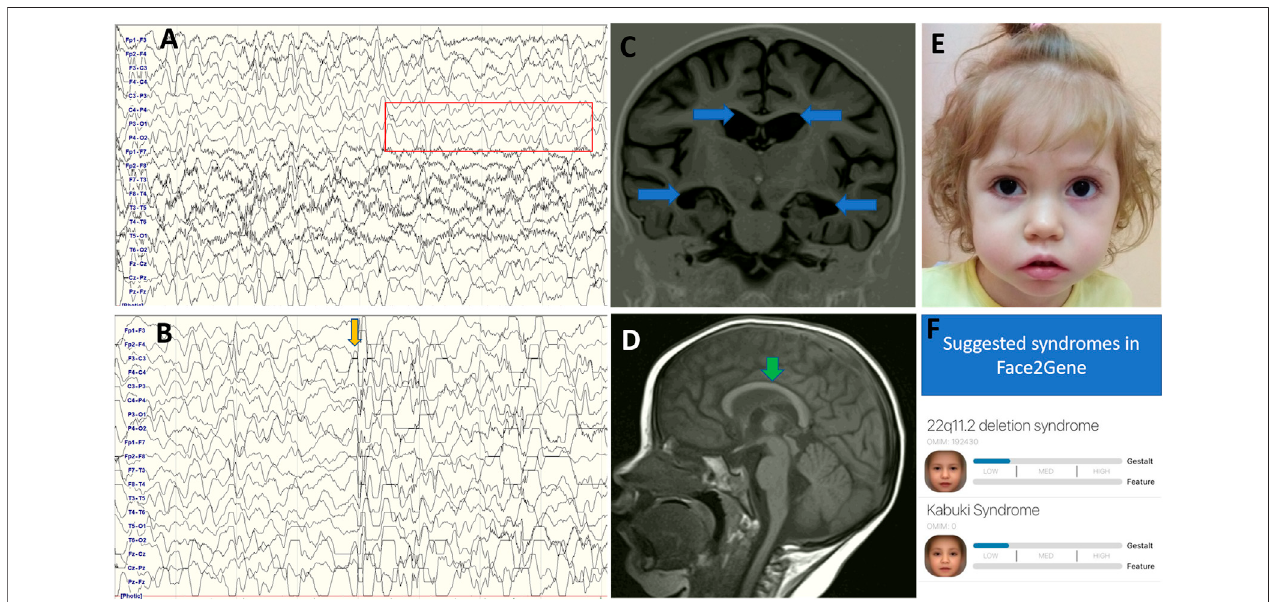
FIGURE 1| EEG longitudinal bipolar montage. Sweep: 30 mm/s; sensitivity: 150 mV/mm; bandpass: 1 – 70 Hz. Awake EEG (A) showing slow background activity with normal posterior dominant rhythm. Ictal EEG recording (B) showing myoclonic jerks with diffuse discharge and bursts of slow waves. 1.5T axial (C) and sagittal (D) T1 MRI indicated a mild diffuse brain atrophy, bilateral ventriculomegaly (blue arrows), and thinning of the corpus callosum (green arrows). Facial features (E) including a pronounced double curve of the upper lip (Cupid ’ s bow) and long palpebral fi ssures. Face2Gene analysis (F) showing low overlap with Kabuki